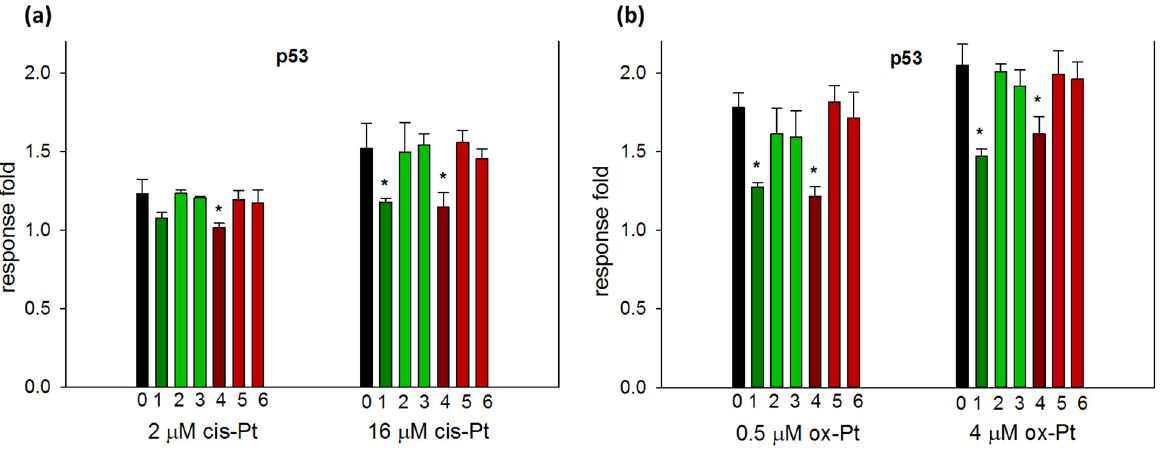
Figure 8. Activation of p53 in NRK-52E cells co-treated with ( a ) cisplatin, ( b ) oxaliplatin, and 1 mM S -carboxyalkylcysteines for 24 h. Codes for the amino acids: 0—no amino acid; 1— β -CEC; 2—(4 R )- β -CECO; 3—(4 S )- β -CECO; 4—CMC; 5—(4 R )-CMCO; 6—(4 S )-CMCO. Responses significantly different from “no amino acid” ( n = 3, p < 0.05) are marked with asterisks.